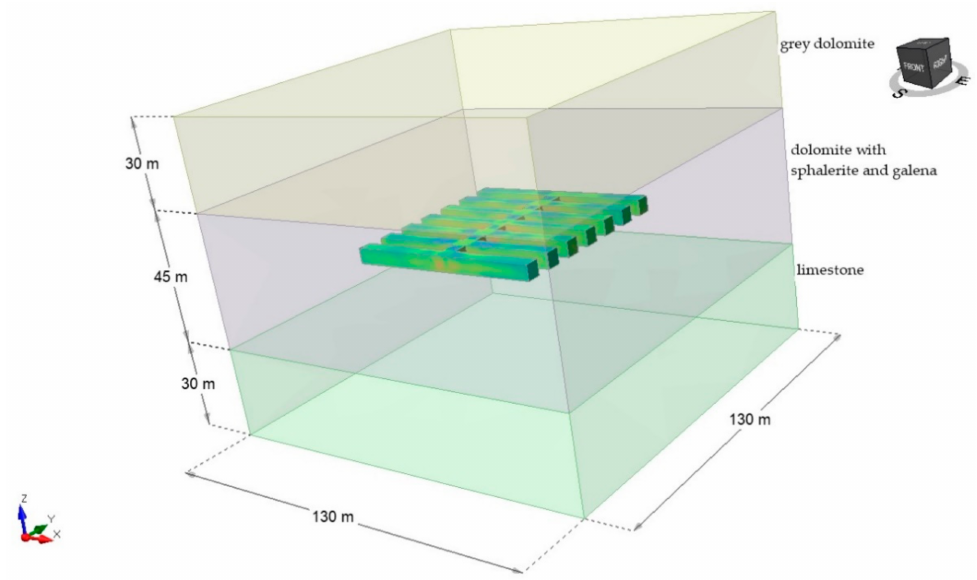
Figure 9. The 3D model of rock